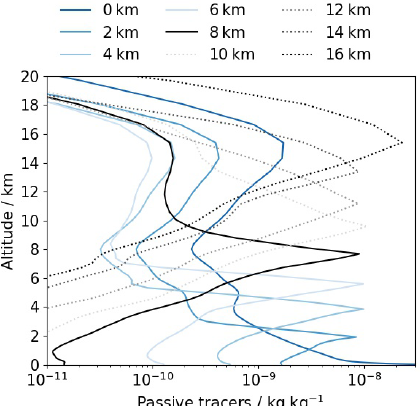
Figure 13. Maps of the mixing ratio of a passive tracer emitted at 13–16km altitude. Mixing ratios are shown at 14km, 9km, 5km and 500m at 21:00UTC on 17 September 2014 (47h after the first release of the tracer). The upper limits in the four maps are